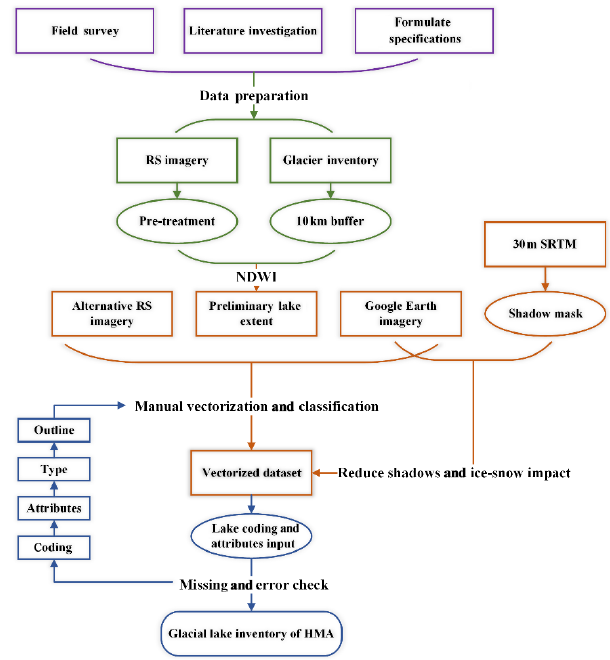
Figure 3. Flow chart of HMA glacial lake inventory.